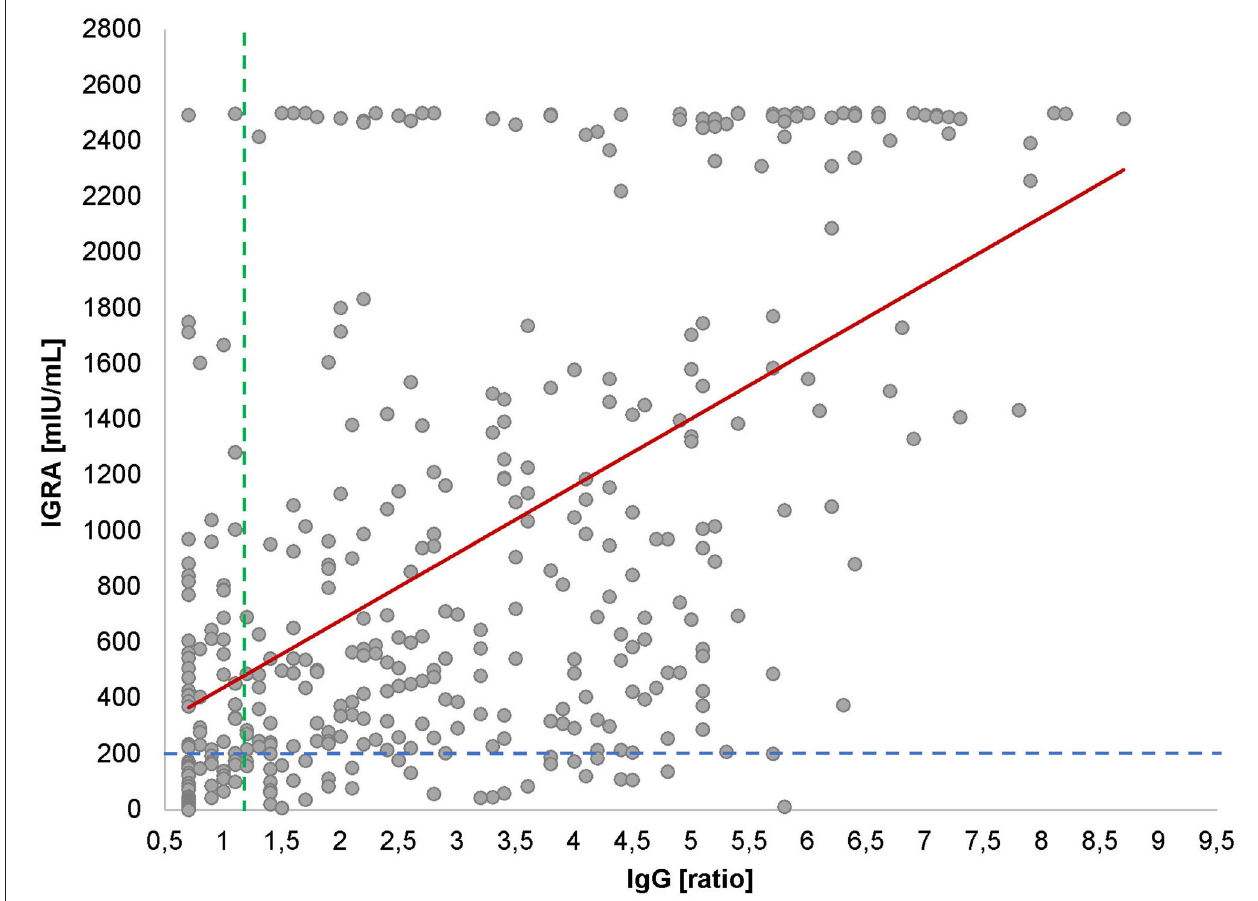
FIGURE 4 | IgG antibodies vs. IGRA. Cross-sectional scatter plot for IGRA and IgG values. Each black dot represents one participant and the respective IgG and IGRA values. The dotted line represents the cut-off for positive IgG values at 1.1 (vertical line) and for IGRA values at 200 mIU/ml (horizontal line). The red line shows the significant positive correlation between IgG and IGRA values ( r = 0.6, p <